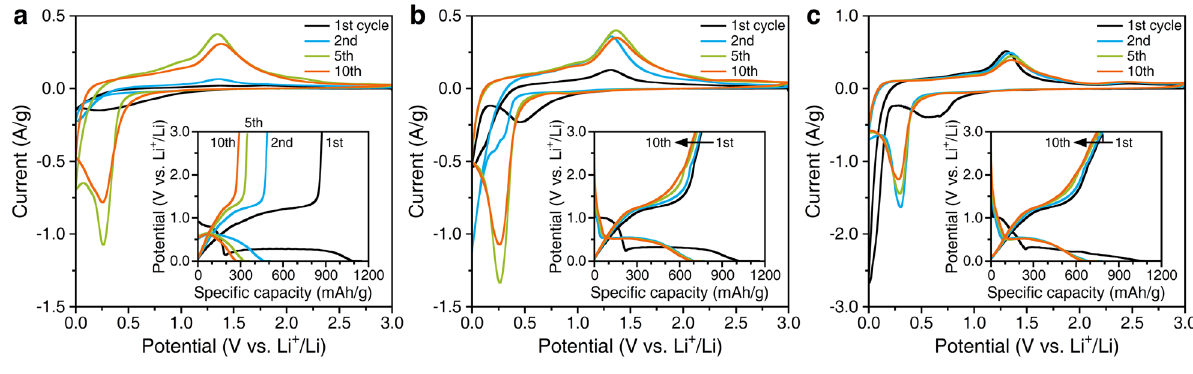
Figure 6. CV curves and charge–discharge curves (inset) of ( a ) bare Mn 3 O 4 , ( b ) Mn 3 O 4 /C-7, and ( c ) Mn 3 O 4 /C-33 composite